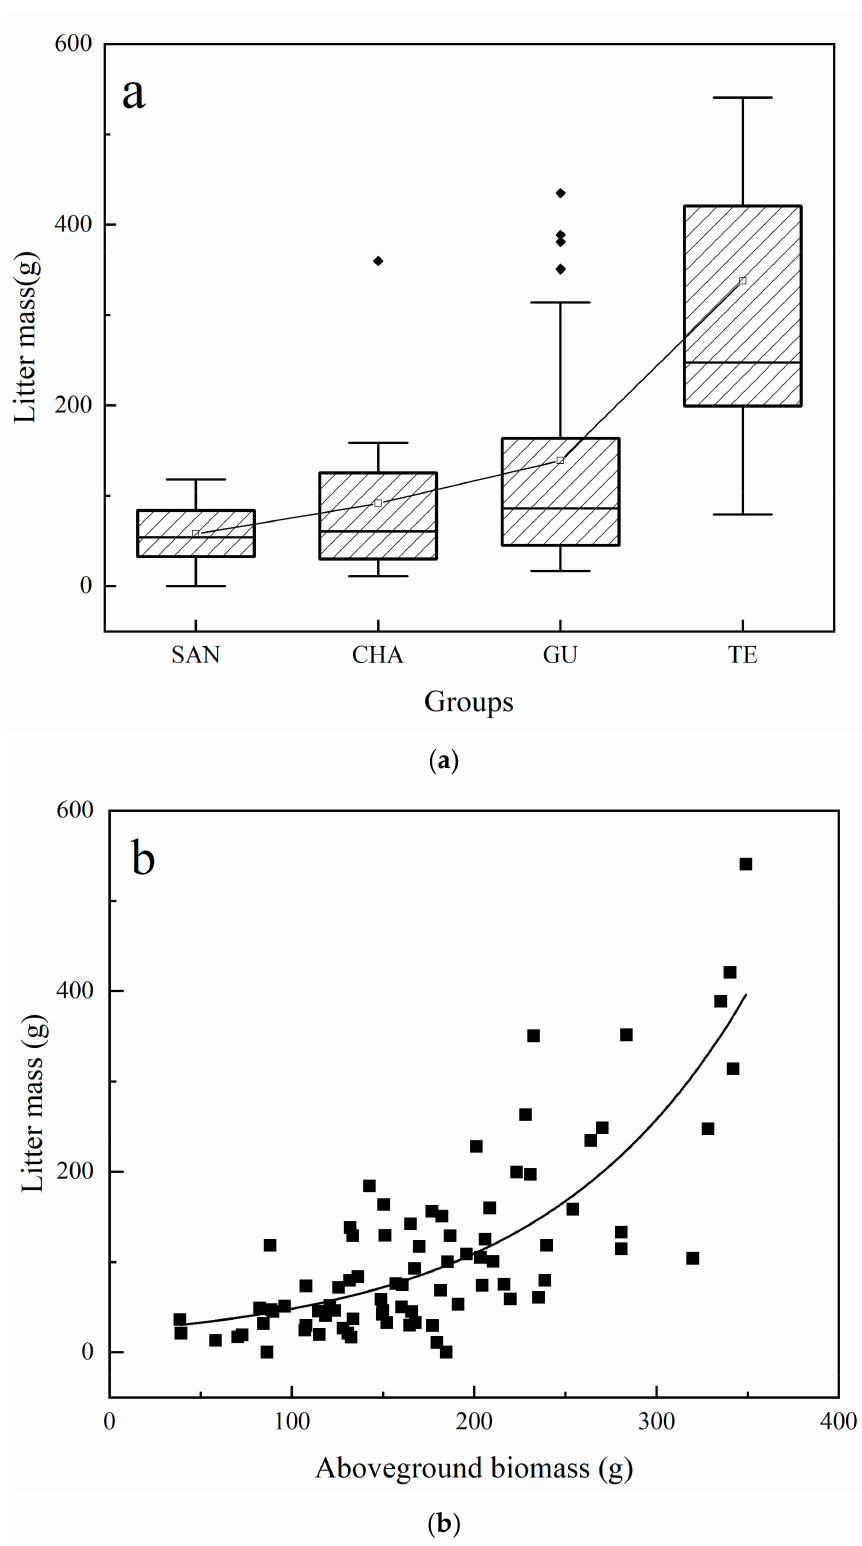
Figure 4. ( a ) Boxplot of the various sample squares’ litter accumulation in the four sample meadows. ( b ) Nonlinear fitting of biomass and litter mass of all sample square in four sampled meadows. y = a + be cx , P <